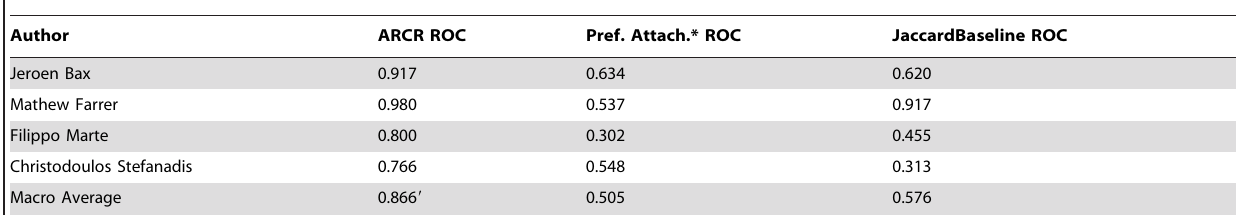
Table 5. IndividualAuthorCategory evaluation results.